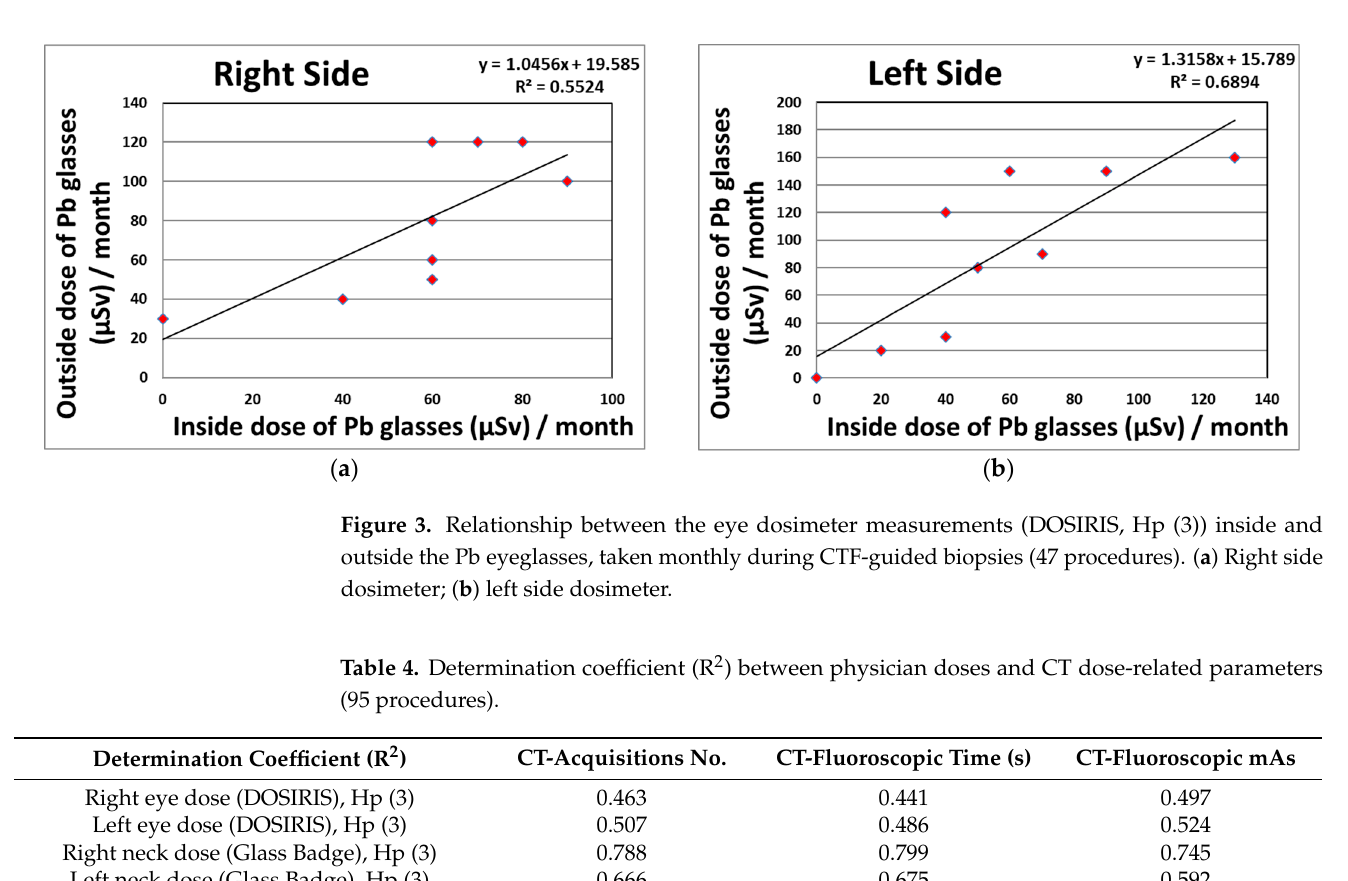
Figure 2. Relationship between the eye dosimeter (DOSIRIS, Hp (3)) and neck dosimeter (Glass Badge, Hp (3)), taken monthly during CTF-guided biopsies (95 procedures). ( a ) Right side dosime- ter; ( b ) left side dosimeter.